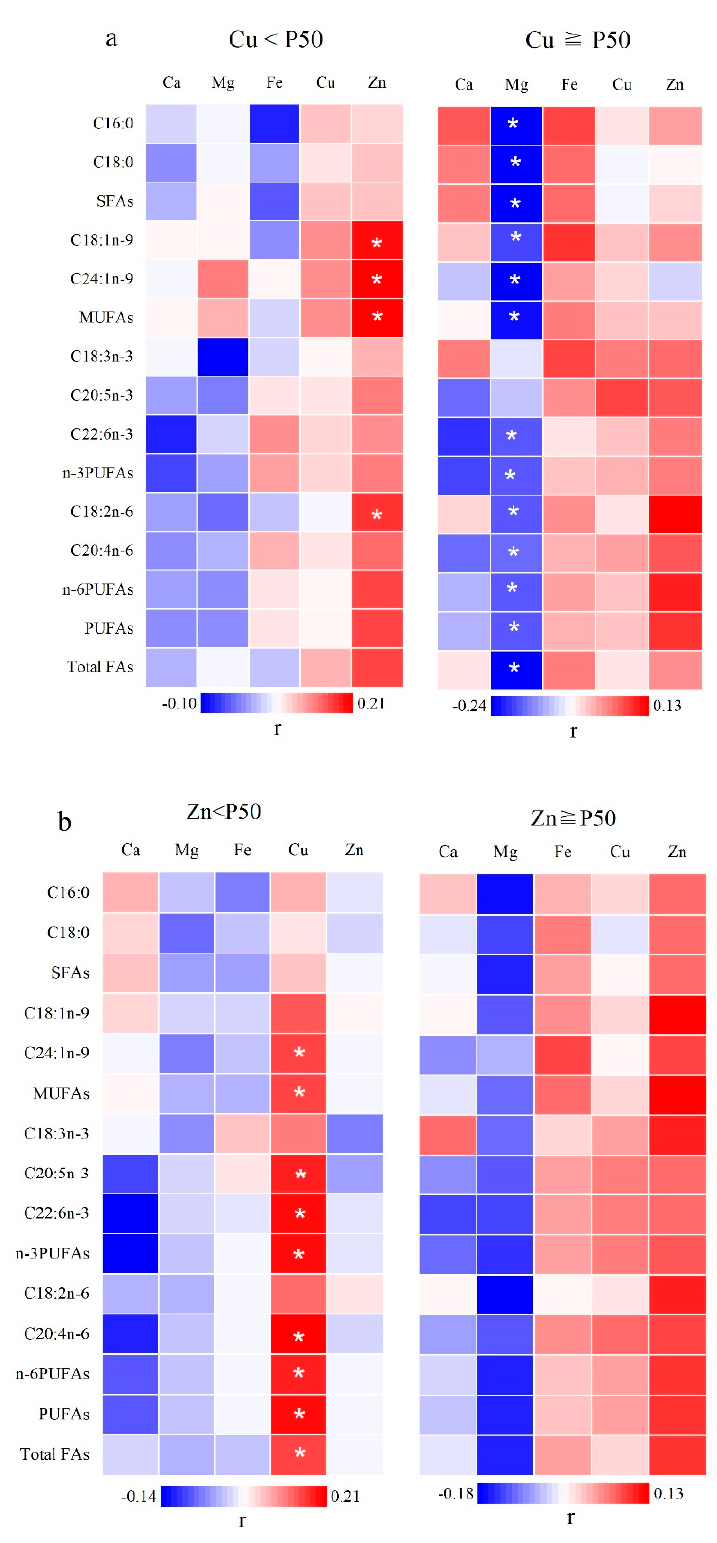
Figure 3. Partial correlation analysis of mineral elements with erythrocyte FAs in children. ( a ) According to P50 stratification of whole blood Cu status. ( b ) According to P50 stratification of whole blood Zn status. r: partial correlation coefficients adjusting for age and sex. * p < 0.05, the p − value was adjusted using false discovery rate method for multiple testing. Abbreviations: SFAs — saturated fatty acids; MUFAs — monounsaturated fatty acids; PUFAs — polyunsaturated fatty acids; P50 — the 50th percentile.